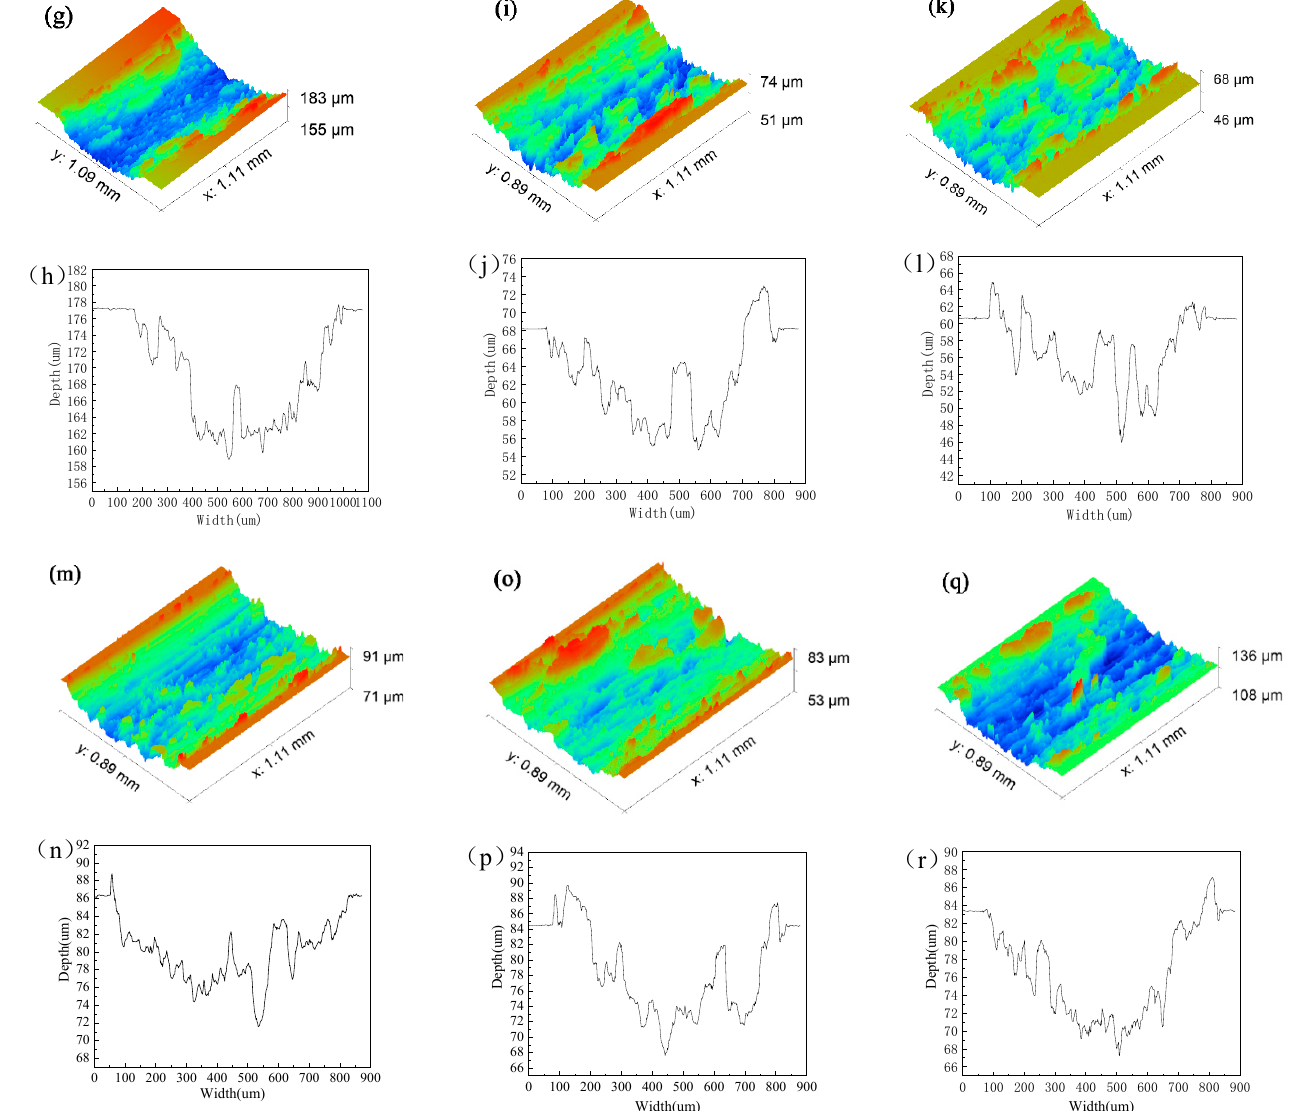
Figure 5. Morphology and depth of wear marks of different samples: ( a , b ) nanosecond texture rotation radius 15 mm; ( c , d ) nanosecond texture rotation radius 18 mm; ( e , f ) nanosecond texture rotation radius 22.5 mm; ( g , h ) picosecond texture rotation radius 15 mm; ( i , j ) picosecond texture rotation radius 18 mm; ( k , l ) picosecond texture rotation radius 22.5 mm. ( m , n ) untextured rotation radius 15 mm; ( o , p ) untextured rotation radius 18 mm; ( q , r ) untextured rotation radius 22.5 mm.